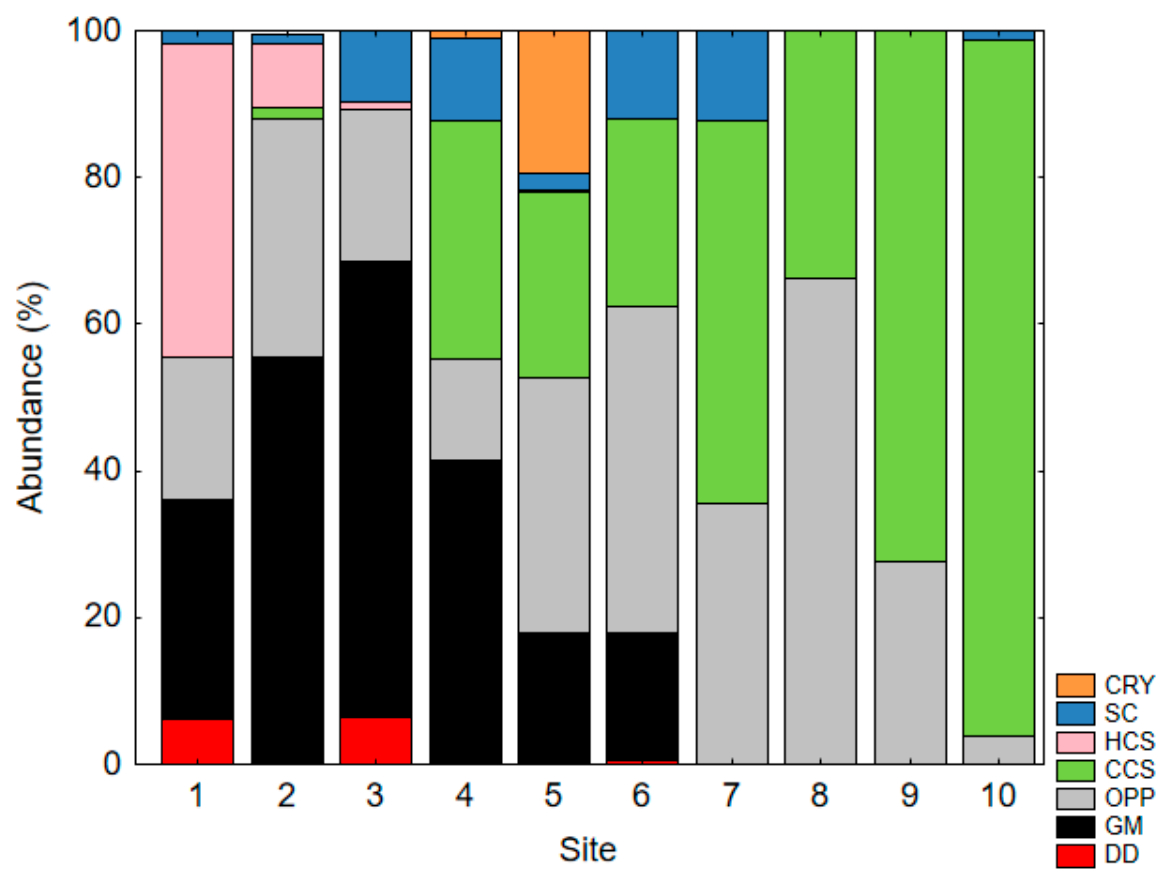
Figure 5. Functional group composition along a gradient of increasing thermal stress, combining results from the present study with published pitfall trap data. 1. grassland site in Spain [39]; 2. unburnt heathland site in south west France, summer unburnt 1992 sample [40]; 3. two Spanish woodland sites [39]; 4. shrubland sites F1 and F2 of the present study combined; 5. three Italian woodland sites combined [7]; 6. woodland sites F3–F6 of the present study combined; 7. forest sites F7–F10 of the present study combined; 8. woodland sites D2 and D3 of the present study combined; 9. forest sites D5 and D7 of the present study combined; 10. four Finnish forest sites combined (the Control sites of [41]). The functional groups are: DD, Dominant Dolichoderinae; SC, Subordinate Camponotini; HCS, Hot-climate Specialists; CCS, Cold-climate Specialists; CRY, Cryptic Species; OPP, Opportunists; GM, Generalised Myrmicinae.